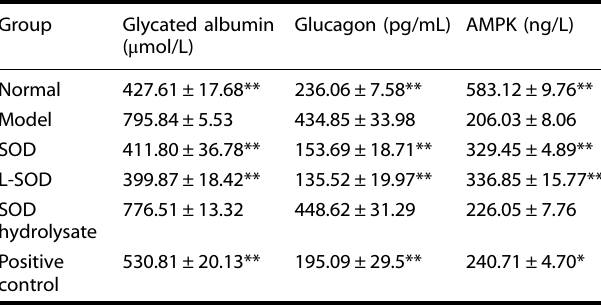
Table 3. Fasting plasma glucose-related indexes of GA, GC, and AMPK.